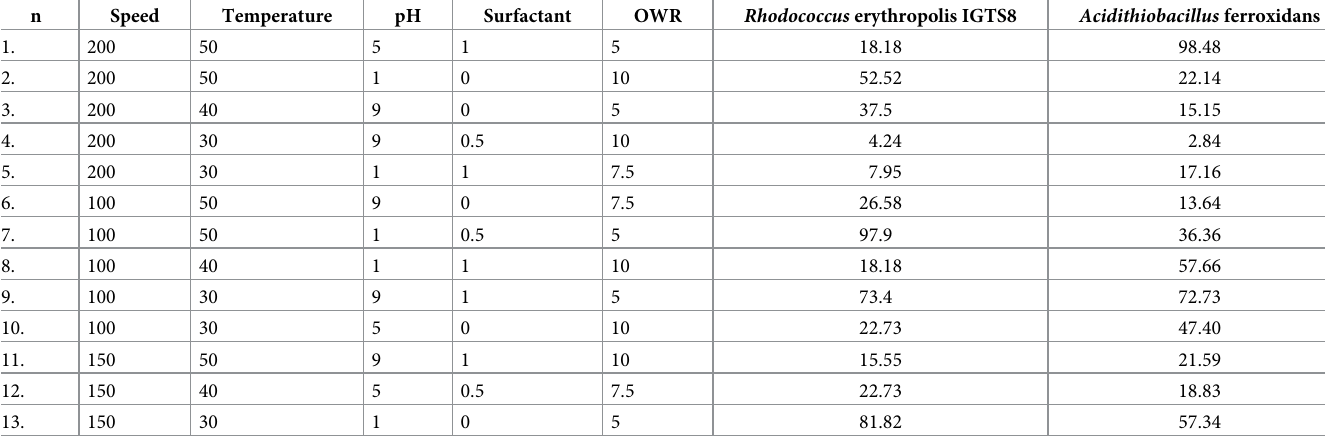
Table 2. Design of experiment by Definitive method and results by both Rhodococcus erythropolis IGTS8 and Thiobacillus